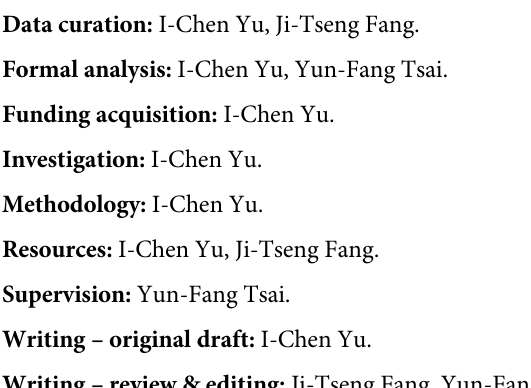
S1 Fig. Patient demands for the two clusters of